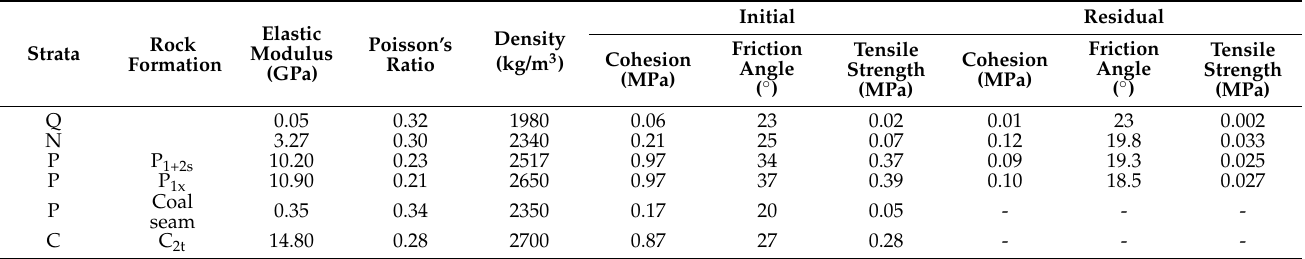
Table 1. The adopted physical–mechanical